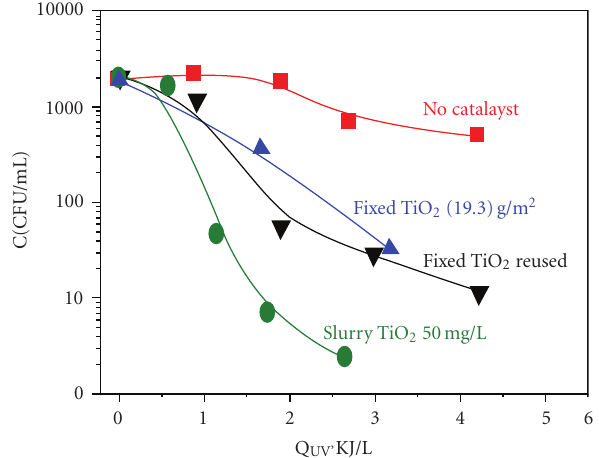
Figure 10: E. coli inactivation (C 0 = 1 × 10 4 CFU/mL) versus Q UV (energy per unit of volume, kJ/L) in the CPC solar photoreactor. Comparison of TiO 2 slurry (50mg/L), with supported photocat- alyst KN47 (19.3g TiO 2 . m − 2 ) and SODIS. With permission from